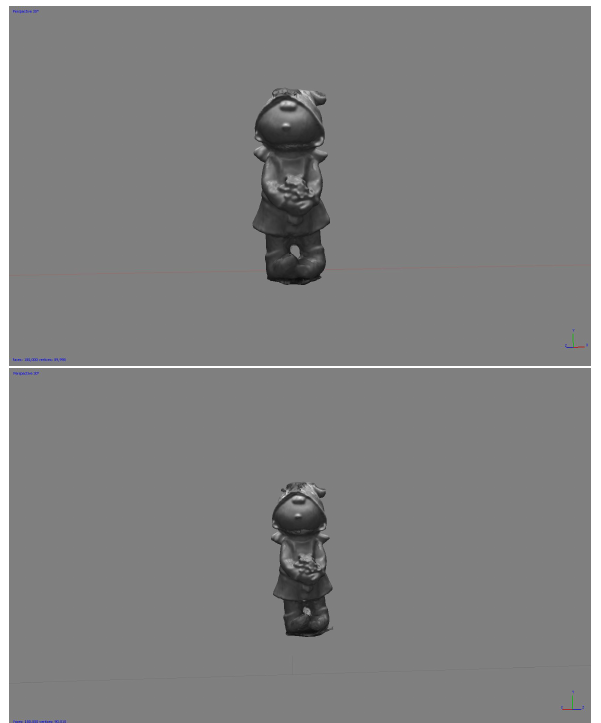
Figure 7. Comparison of the reference model with the 3D model reconstructed using images captured by a human operator (top) and by an agent trained using our RL3D framework